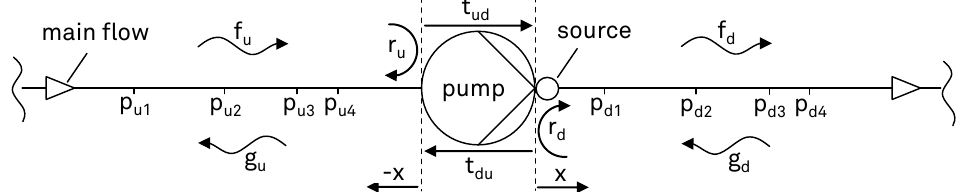
Figure 3. Four-pole representation of the pump via scattering parameters.